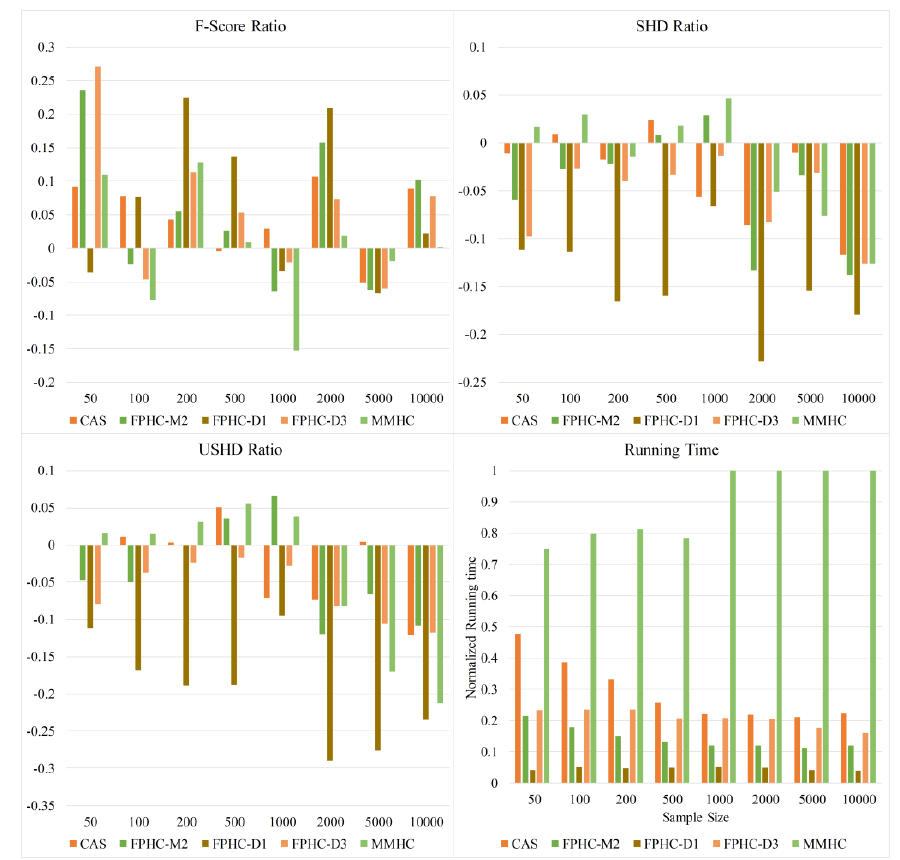
Figure 7. The performance comparison of different sample sizes and methods on the Hailfinder network.